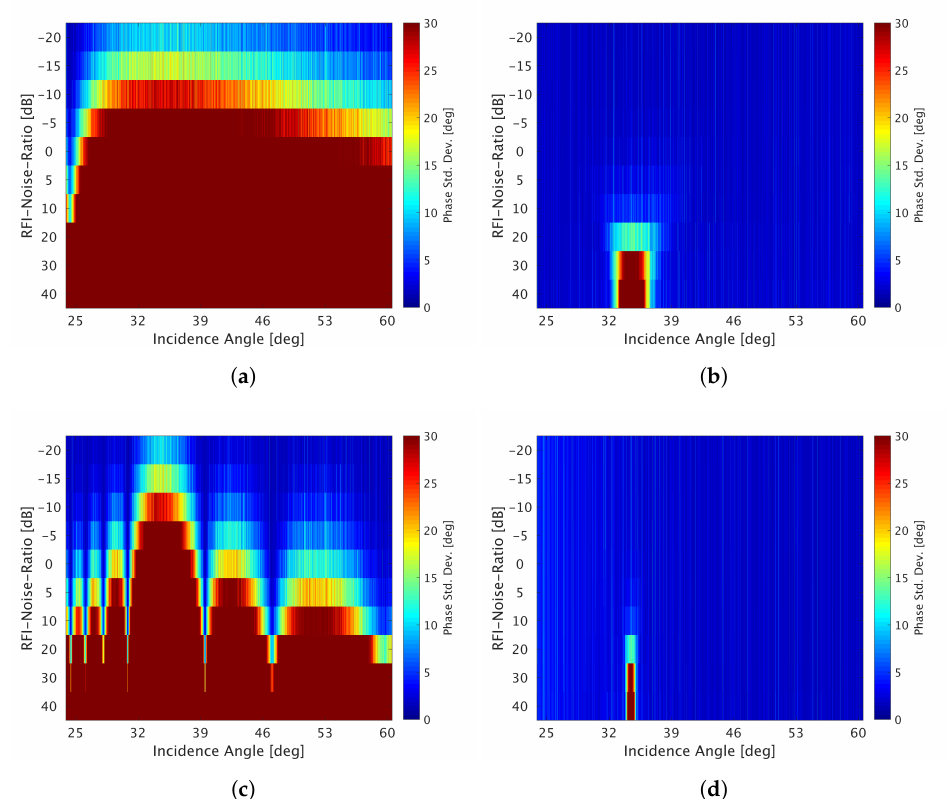
Figure 26. The phase standard deviation of the residual error image of scenario B for different RFI-Noise-Ratios versus the incidence angle of the instantaneous SAR signal. The SNR is 37.36 dB. ( a ) No RFI mitigation for N = 8, ( b ) After RD-Frequency MVDR beamforming for N = 8, ( c ) No RFI mitigation for N = 32, ( d ) After RD-Frequency MVDR beamforming for N =